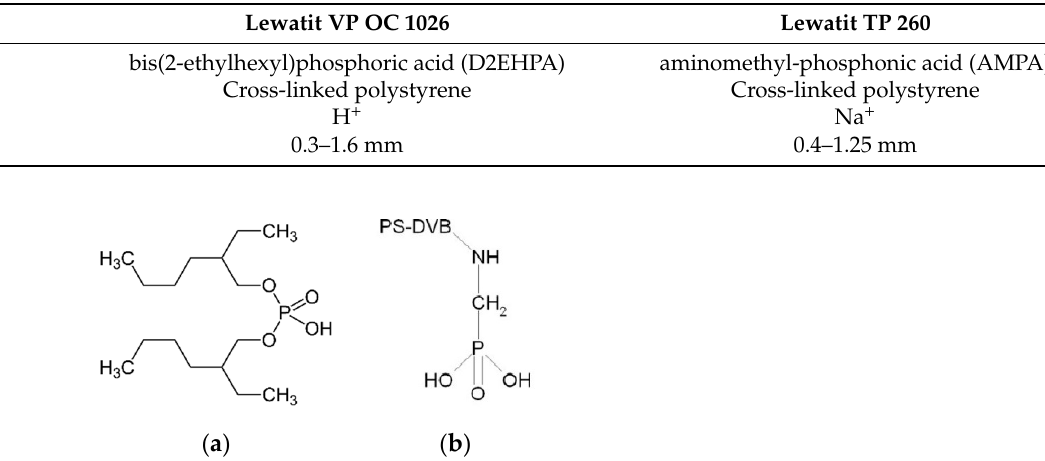
Table 1. Resins characteristics.